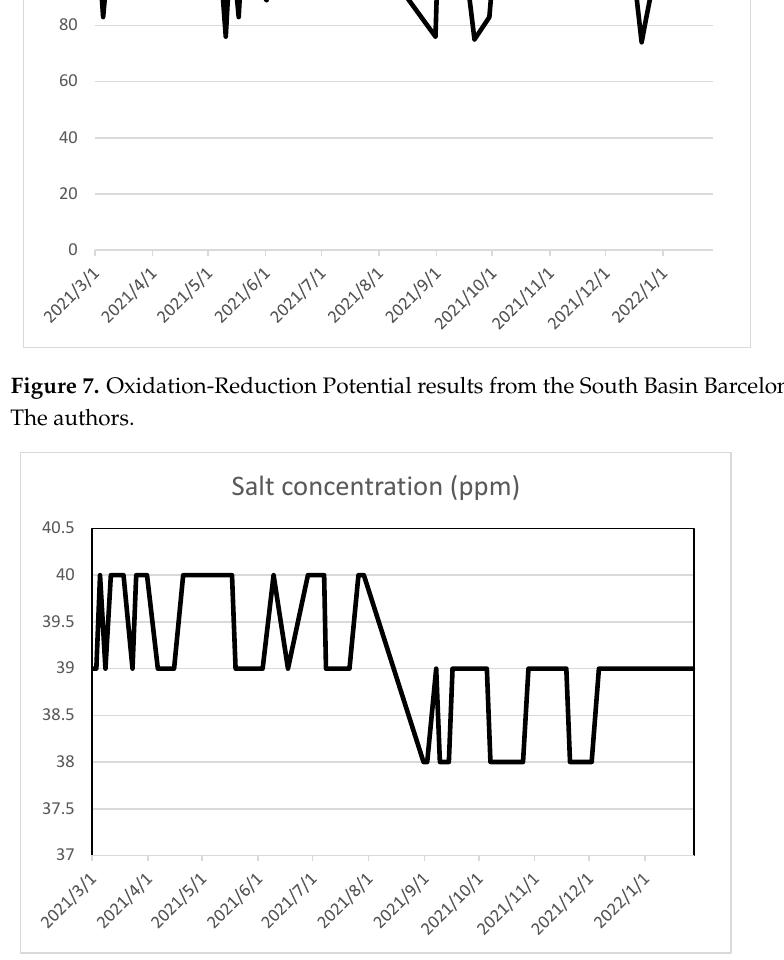
Figure 8. Salt concentration results from the South basin Barcelona port water. Source: The authors.